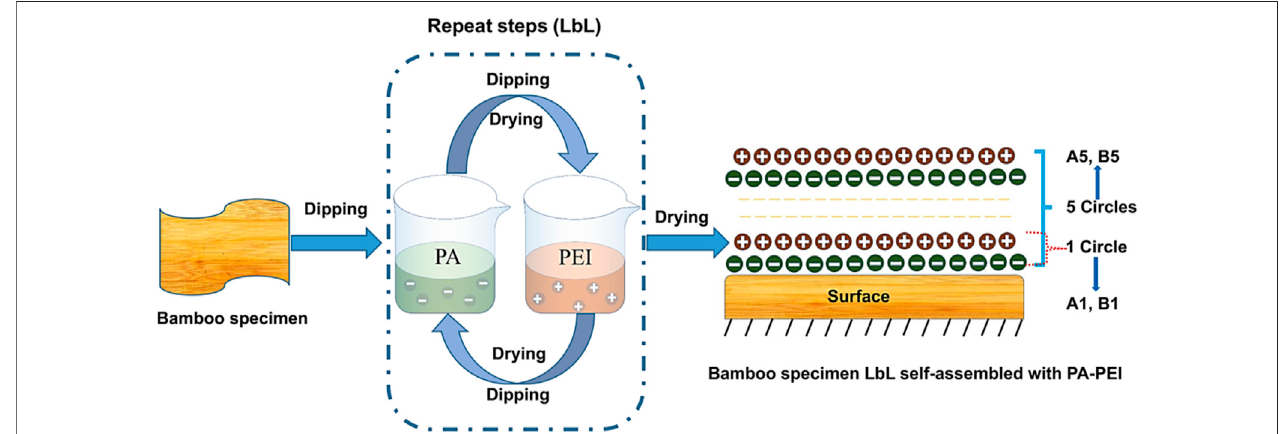
FIGURE 1 | Diagrammatic representation of bamboo specimens LbL self-assembly with PA-PEI.